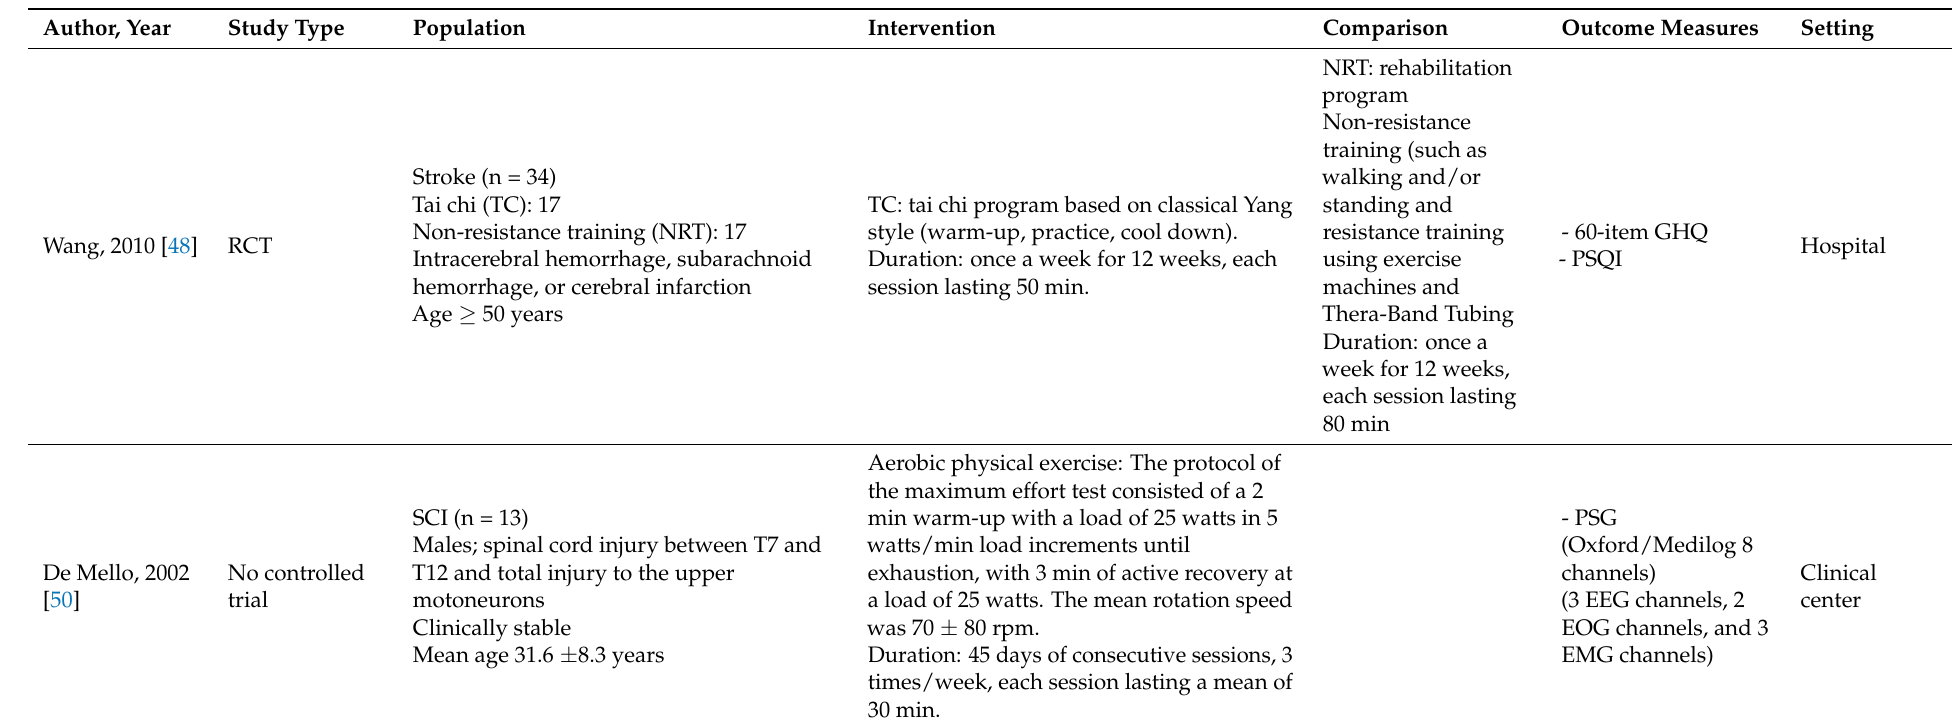
Aerobic physical exercise: The protocol